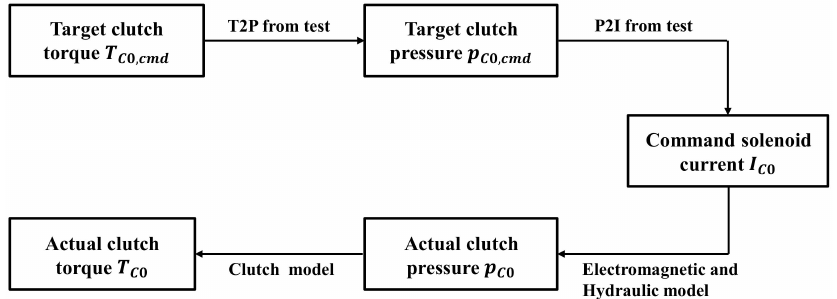
Figure 7. Flow chart of EDC control process in simulation.